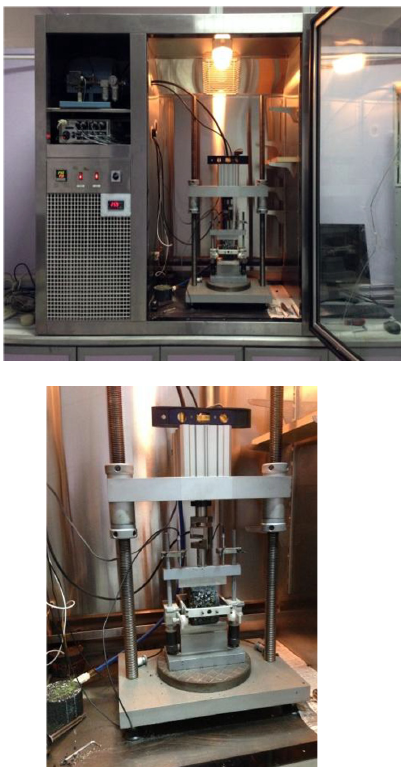
Fig. 3. The indirect tensile fatigue test apparatus